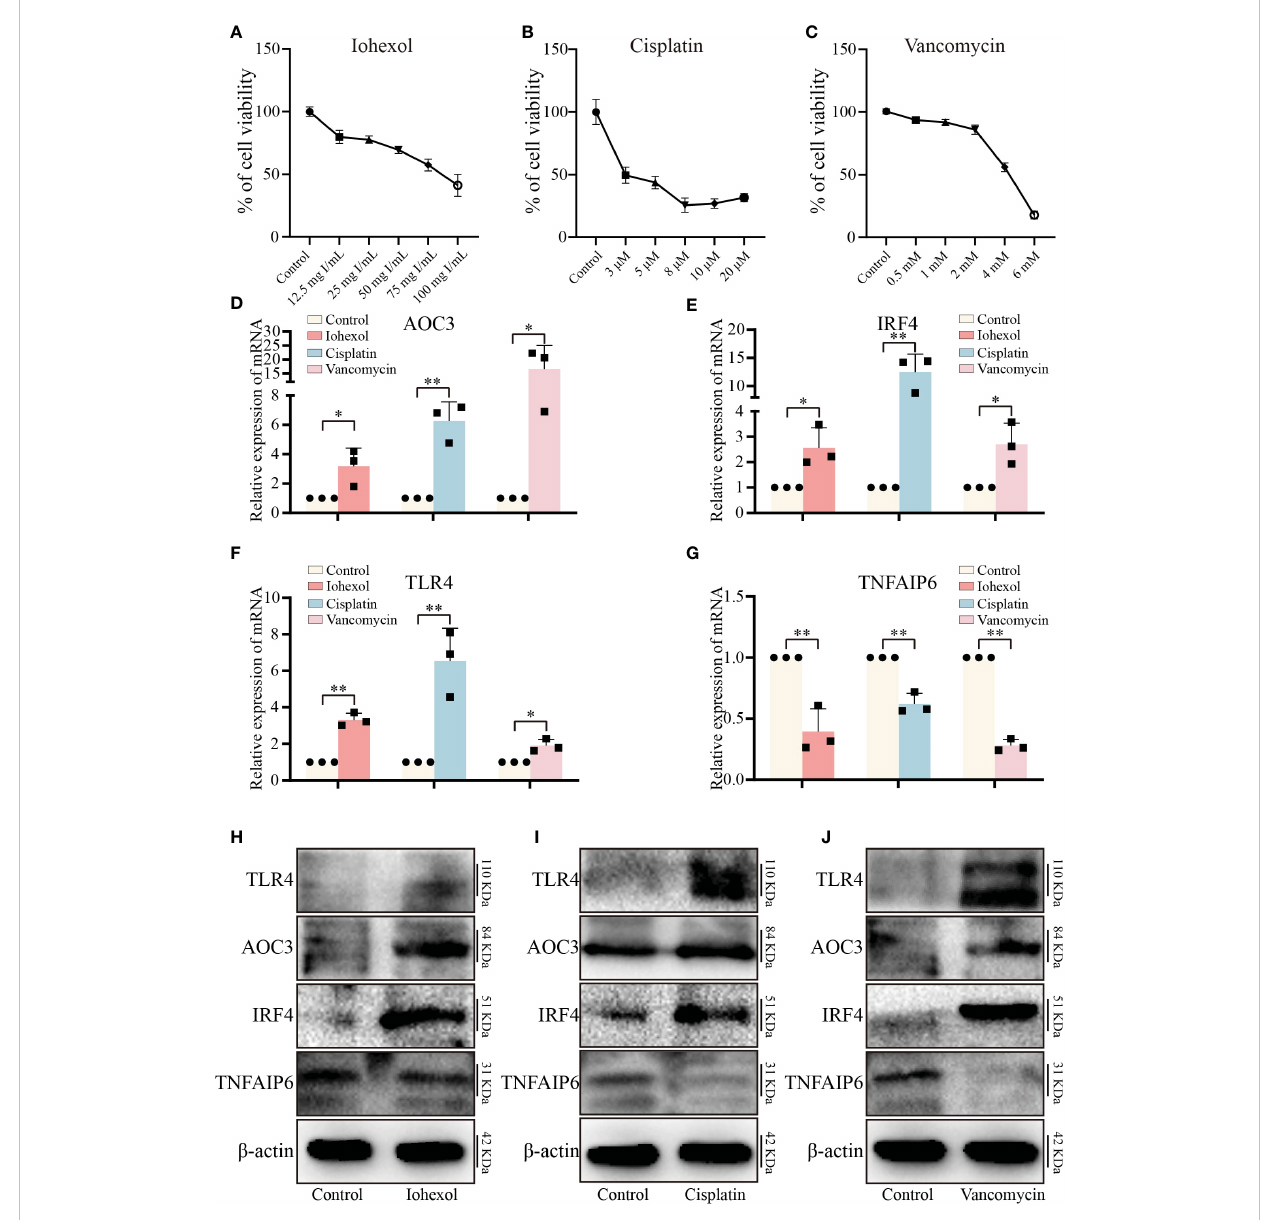
FIGURE 5 Validation of hub genes in vitro . (A – C) The variations in relative cell viability of HK-2 cells as the concentration of iohexol, cisplatin or vancomycin dosage increased. (D) The mRNA expression level of AOC3 under the treatment of iohexol, cisplatin or vancomycin compared with controls. (E) The mRNA expression level of IRF4 under the treatment of iohexol, cisplatin or vancomycin compared with controls. (F) The mRNA expression level of TLR4 under the treatment of iohexol, cisplatin or vancomycin compared with controls. (G) The mRNA expression level of TNFAIP6 under the treatment of iohexol, cisplatin or vancomycin compared with controls. (H) Representative pictures of the AOC3, IRF4, TLR4, and TNFAIP6 protein levels of the iohexol-induced AKI in vitro . (I) Representative pictures of the AOC3, IRF4, TLR4, and TNFAIP6 protein levels of the cisplatin-induced AKI in vitro . (J) Representative pictures of the AOC3, IRF4, TLR4, and TNFAIP6 protein levels of the vancomycin-induced AKI in vitro . Each result was repeated at least three times. Compared with the control group, * p < 0.05; ** p <